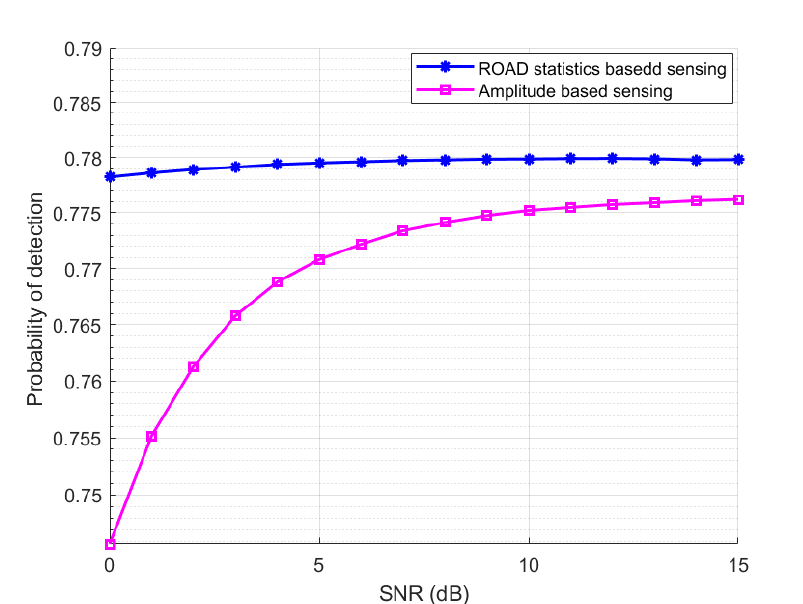
Figure 14. Probability of detection vs. SNR.